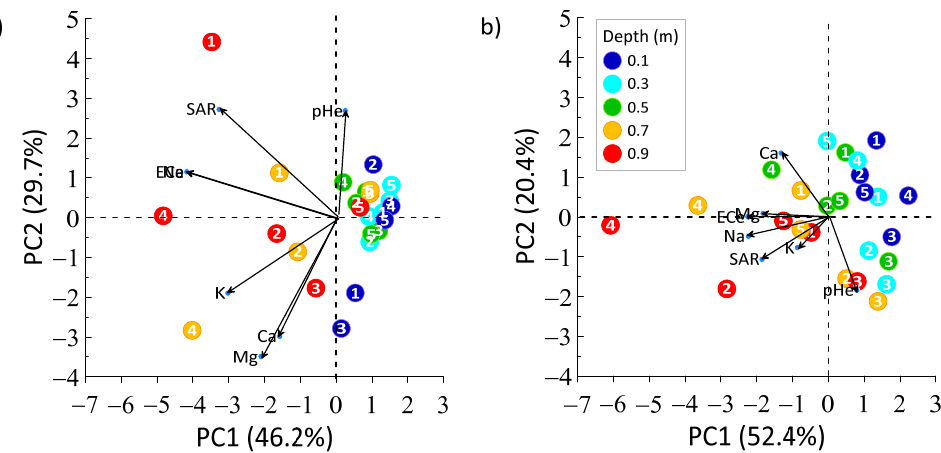
Figure 4. Biplot with results of the PCA for the considered soil properties (pHe, ECe, SAR, [Na + ], [Ca 2+ ], [Mg 2+ ] and [K + ]) in ( a ) 2017 and ( b ) 2020. Individual soil samples are represented by point numbers (1–5, Figure 1) and depth.